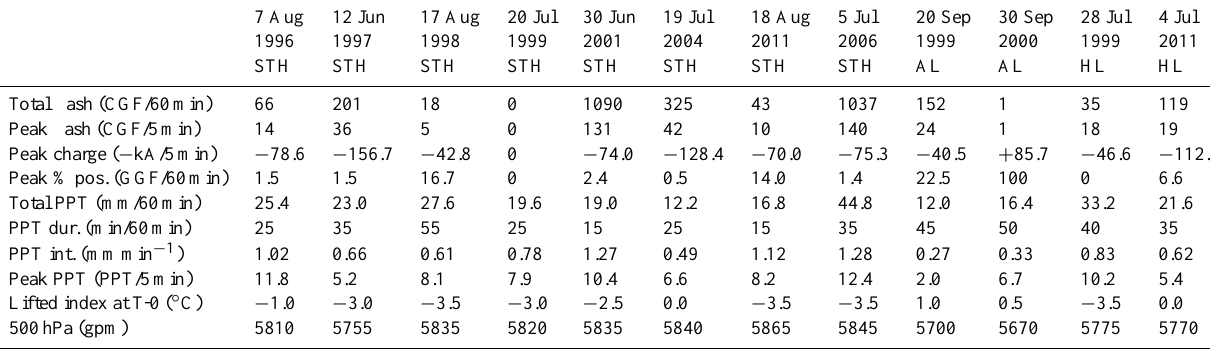
Table 2. Summary of critical interval variables at meso- β